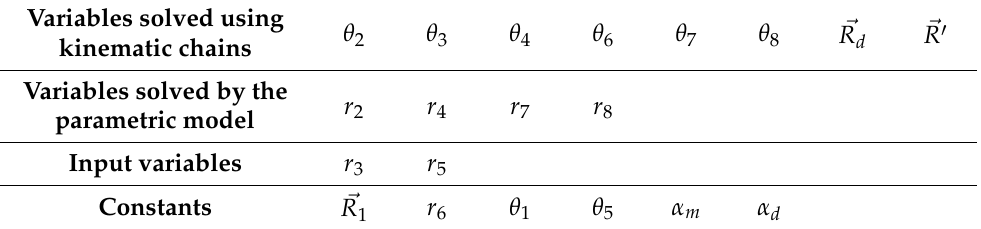
Table 1. Variables and constants for mechanism